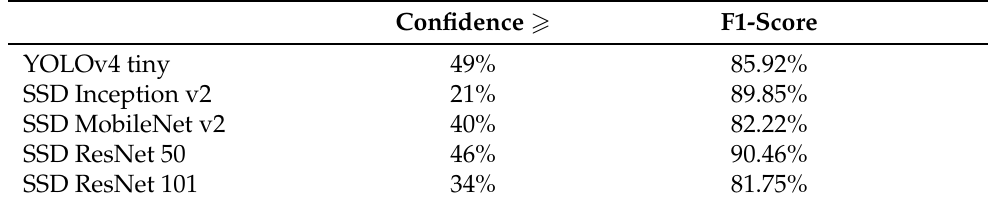
Table 4. Confidence threshold for each DL model that optimises the F1-score metric.